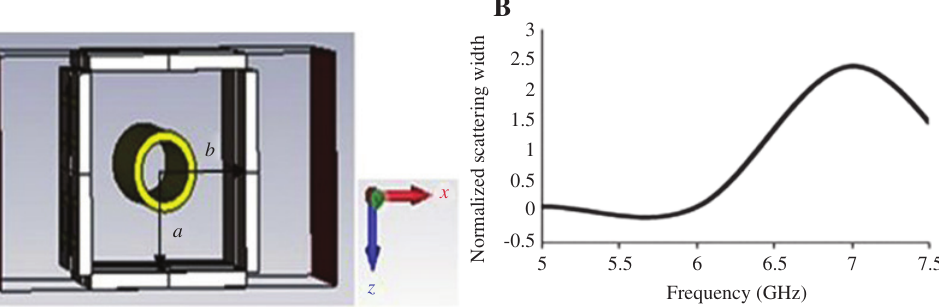
Figure 11: (A) Simulation geometry of the rectangular cloak with metal cylinder (inside) and (B) calculated result of normalized scattering width of cloaked object normalized to scattering width of bare object for the rectangular cloak.